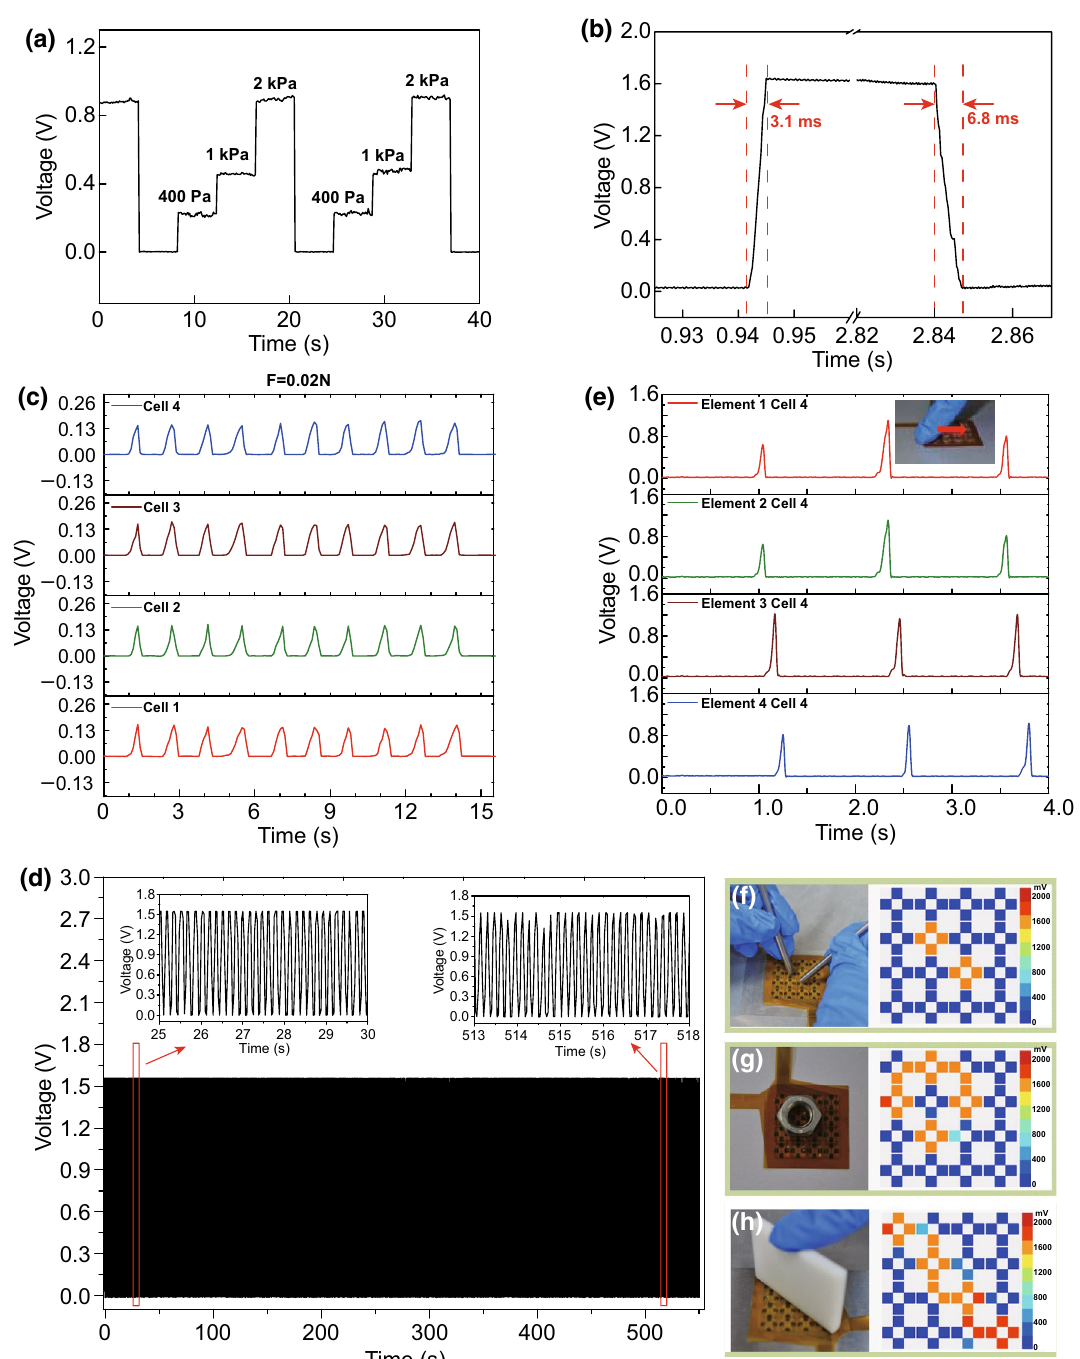
Fig. 5 a The dynamic voltage response of the sensor under repeated various pressures. b Response and recovery time with 5 kPa loading and unloading. c Dynamic voltage responses of four cells with continuous loading and unloading of 0.02 N. d Good repeatability and durability after continuous about 4000 pressing–releasing cycles. e Voltage responses of different cells in the same row under a finger sliding. f – h Pressure dis- tribution of sensor array with quantitative color under the case of double points pressing, circle pressing and diagonal